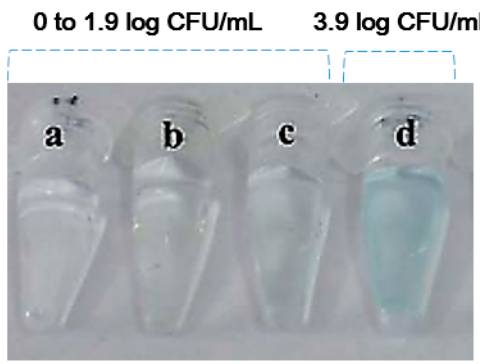
Figure 2. Absorption-profile of AuPt-adsorbed E. coli O157:H7 in the absence of bacteria (transparent, no color changes, ( a )), due to the addition of 0.8 ( b ), 1.9 ( c ), and 3.9 ( d ) log CFU/mL of E. coli O157:H7. Adopted and reproduced from Su et al. [32] with permission from the Royal Society of Chemistry.